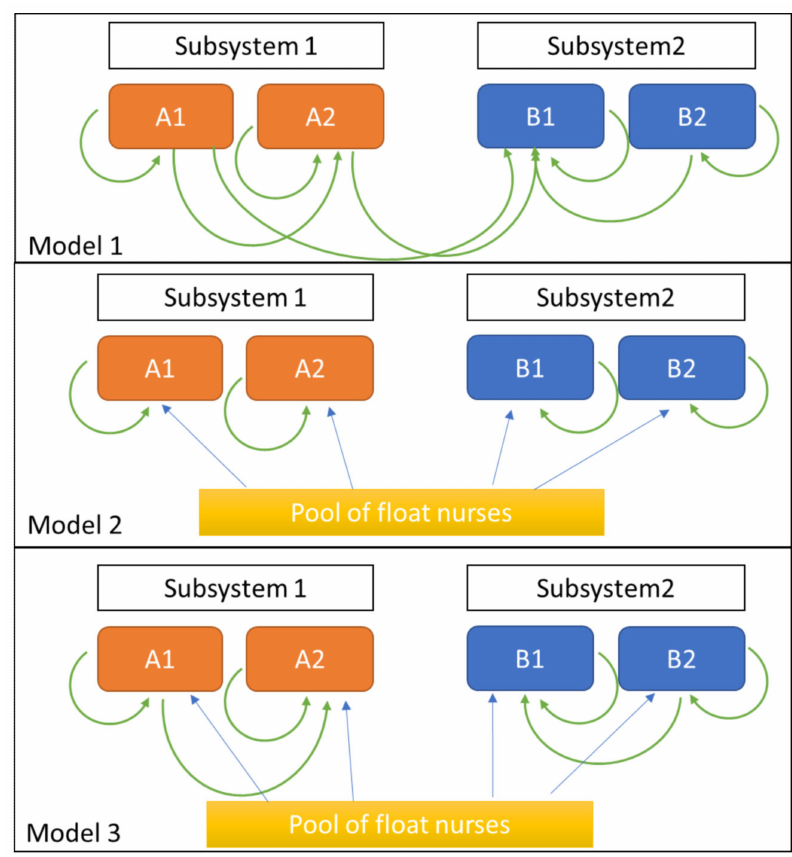
Figure 1. Nurse flexibility strategies, as explained in Section 2.2.